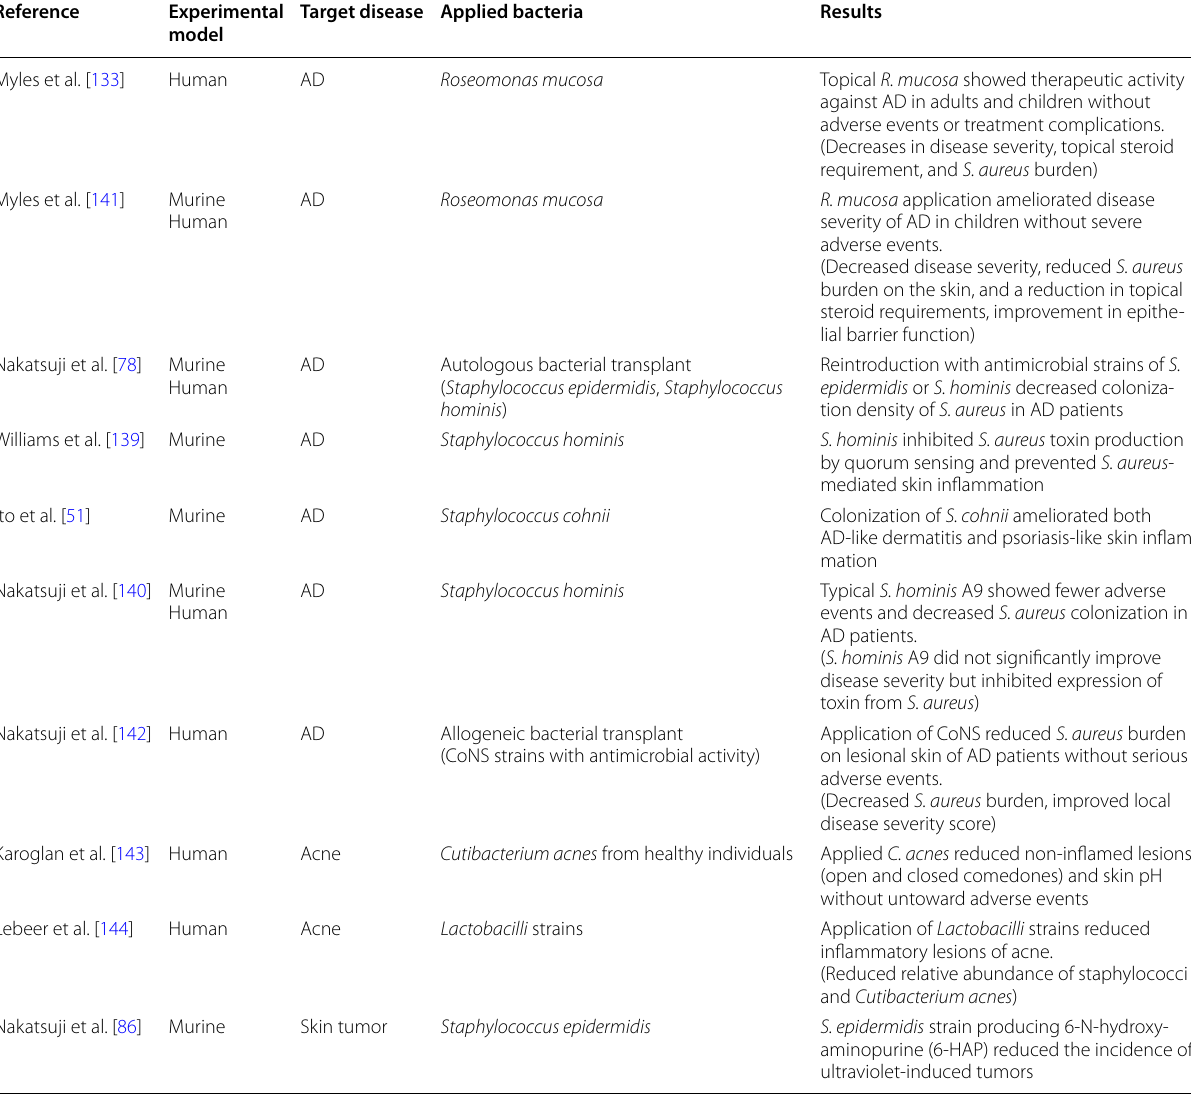
AD , atopic dermatitis; CoNS , coagulase-negative